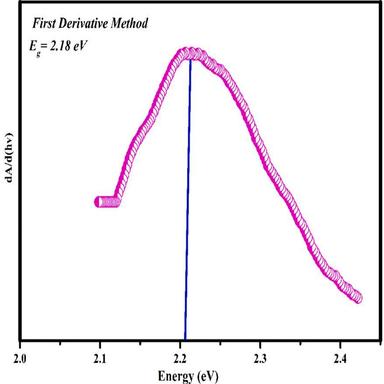
First derivative method for determining the energy bandgap of the material.